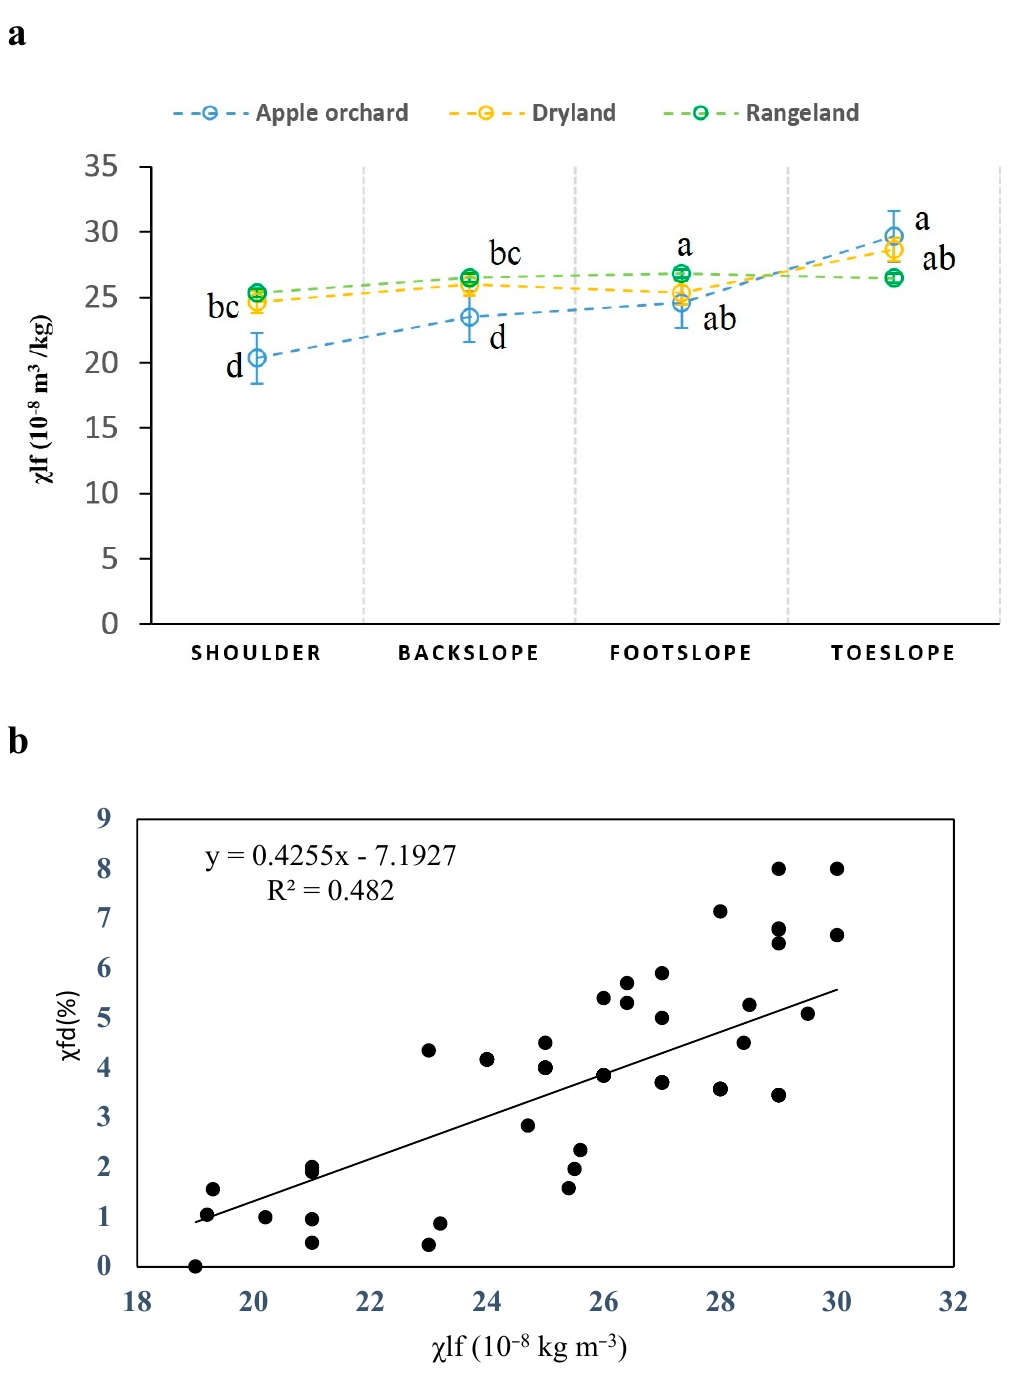
Figure 4. Variability in magnetic susceptibility ( χ lf ) at three land uses in four slope positions ( a , b ) the relationship between χ lf and χ fd for all studied soil samples. Means with the same letter are significantly different using the least significant difference (LSD) test at p < 0.01.